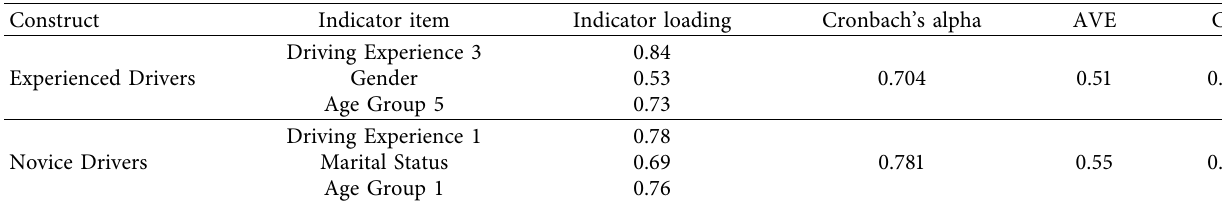
Table 8: Measuring each construct’s reliability and